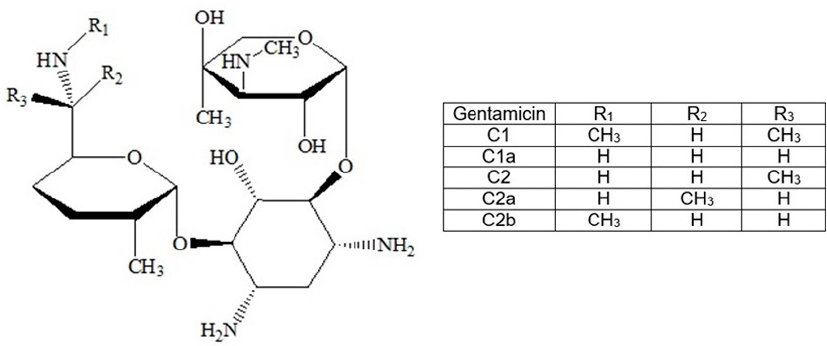
Figure 1. Chemical structure of the most important types of gentamicin.